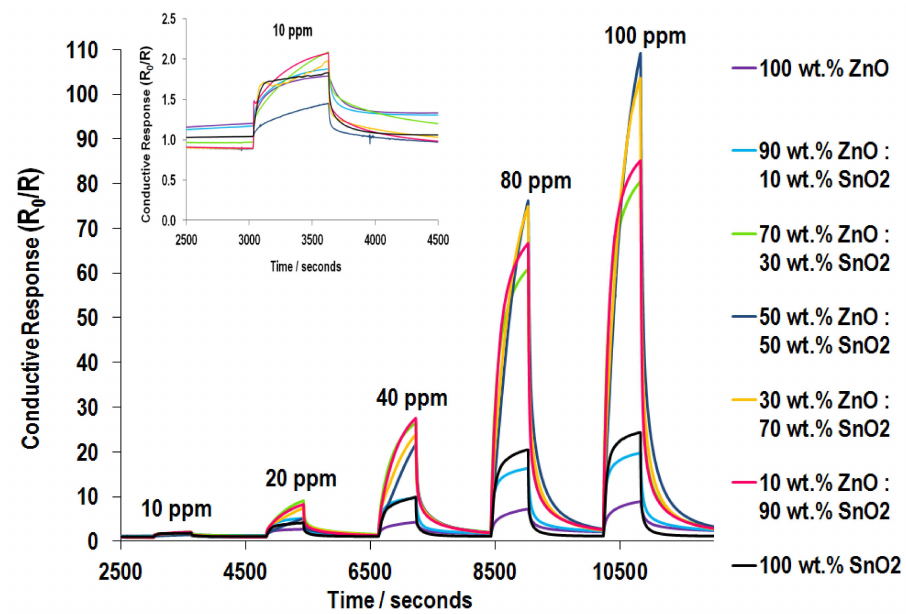
Figure 5. Conductive response traces of the SnO 2 -ZnO array towards 10, 20, 40, 80 and 100 ppm ethanol gas, at an operating temperature of 300 ˝ C. The inset zooms into the conductive response traces of the array against 10 ppm of the analyte. The best response of 110 is observed for the 50 wt% ZnO:50 wt% SnO 2